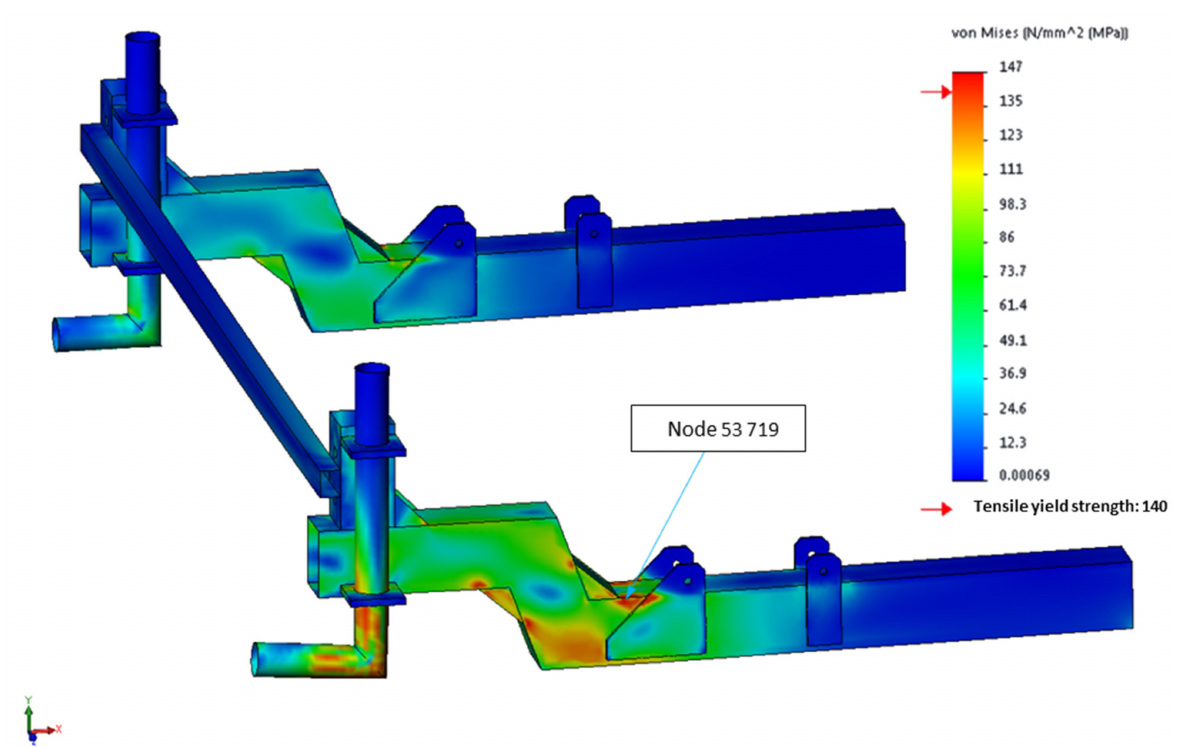
Figure 16. Von Mises’s stress distribution in the optimized ASC crossbar made of aluminium material.